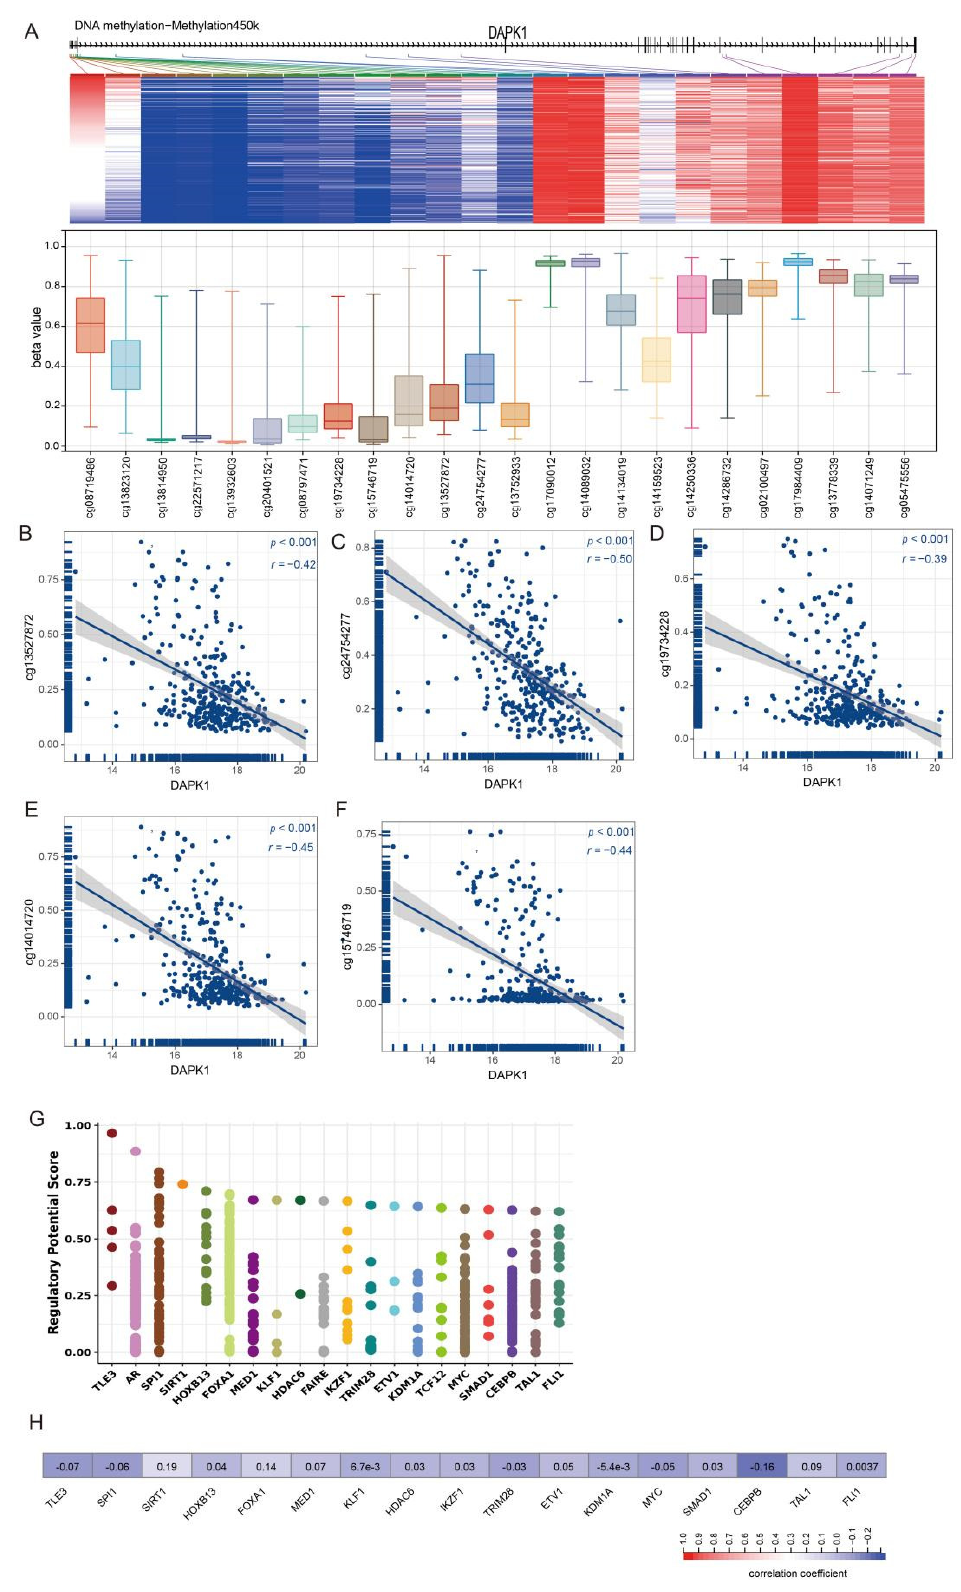
Figure 3. The correlation between the level of DAPK1 and methylation of DAPK1 DNA CpG sites and TF. ( A )The expression value of 24 methylation sites of DAPK1 promoter. ( B – F ) The correlation of DAPK1 with ( B ) cg13527872, ( C ) cg2474277, ( D ) cg19734228, ( E ) cg14014720 and ( F ) cg15746719. ( G ) Top 20 TFs that potentially regulate DAPK1 in different human cancers. ( H ) Correlation be- tween DAPK1 and TF mRNA expression.